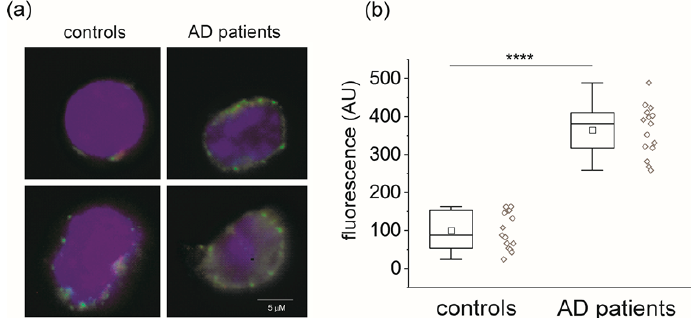
Figure 4. Membrane accumulation of CLIC1 protein in monocytes from AD patients. ( a ) Representative confocal images of transmembrane CLIC1 immunostaining (green) in single monocytes (blue nuclei) obtained from healthy controls (left) and AD patients (right). ( b ) Quantification of CLIC1 membrane fluorescence in single monocytes from control subjects ( n = 15)